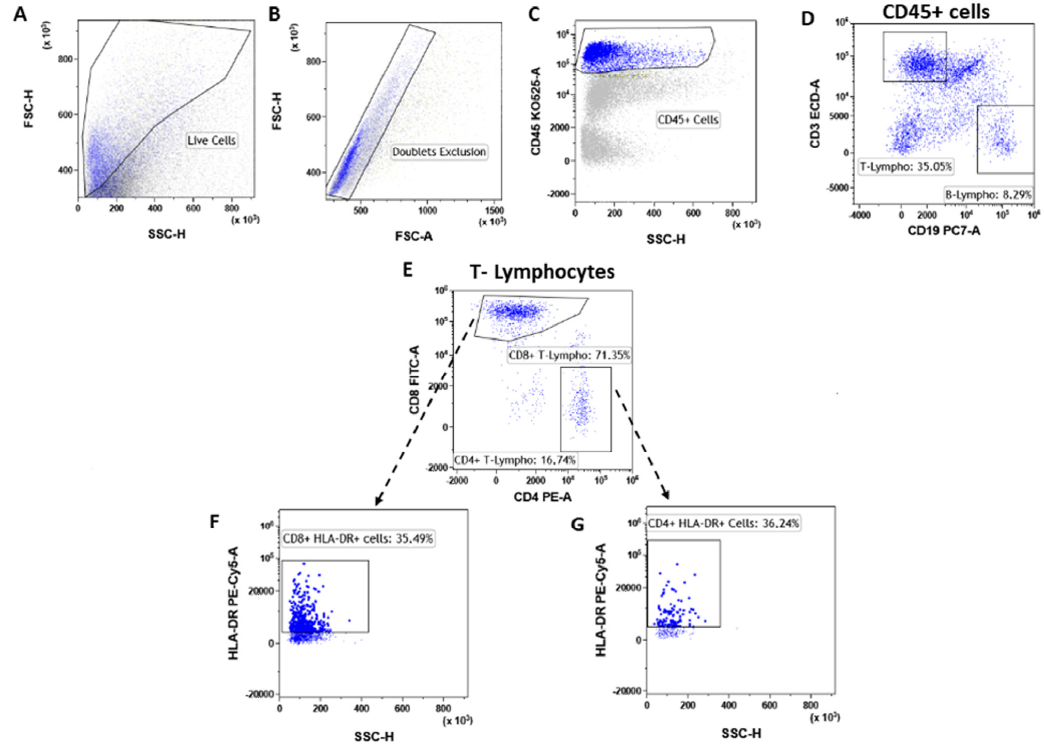
Figure 3. T-lymphocyte subtypes gating strategy. After doublet exclusion ( B ), the immune cells were selected as a CD45+ event ( C ). From the CD45+ cells, we selected the T-lymphocytes as CD45 pos /CD3 pos and B-lymphocytes as CD45 pos /CD19 pos ( D ). Inside the T-lymphocytes we determine the CD8+ T-lymphocytes and CD4+ T-lymphocytes ( E ), which were also assessed for their level of activation by determining the expression levels of HLA-DR ( F , G ).